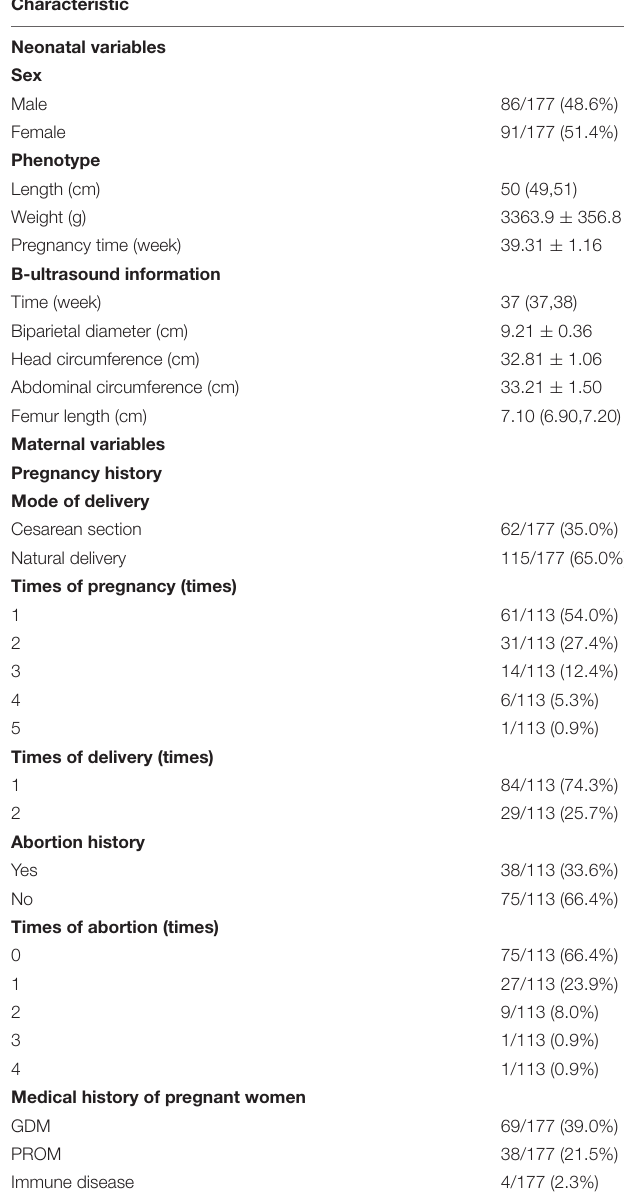
TABLE 1 | Demographic and clinical